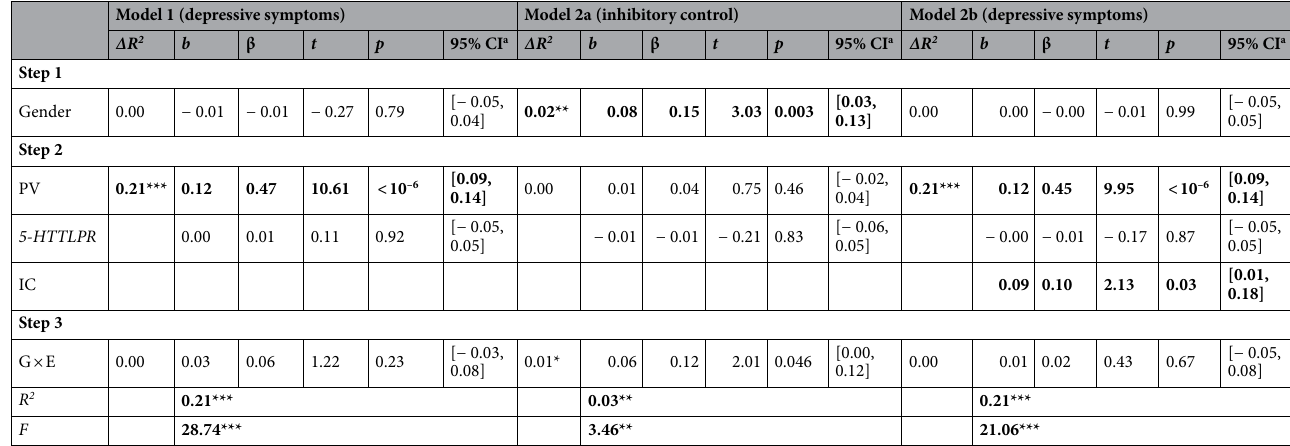
Table 4. Test of mediated moderation in subsample 2. Significant results are highlighted by bold face. PV peer victimization (standardized); IC inhibitory control; G × E 5-HTTLPR × peer victimization. * p < 0.05; ** p < 0.01; *** p < 0.001. a Bootstrapping based confidence